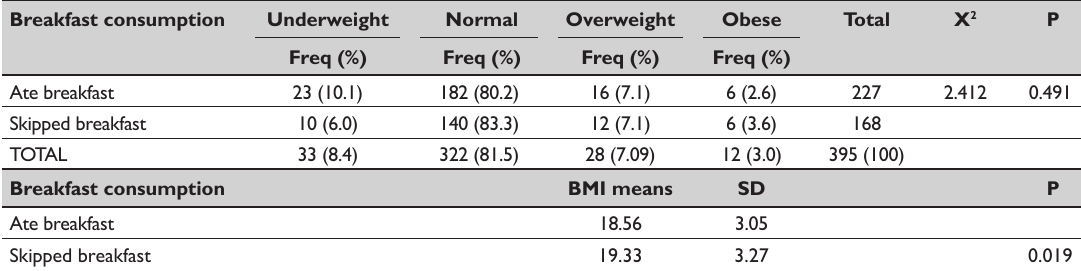
Table 3: Association between breakfast consumption and nutritional status Breakfast consumption Underweight Normal